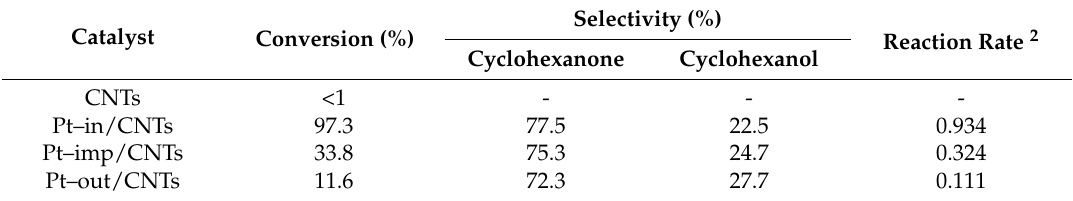
Table 2. Hydrogenation of phenol over Pt–in/CNTs, Pt–imp/CNTs, and Pt–out/CNTs 1